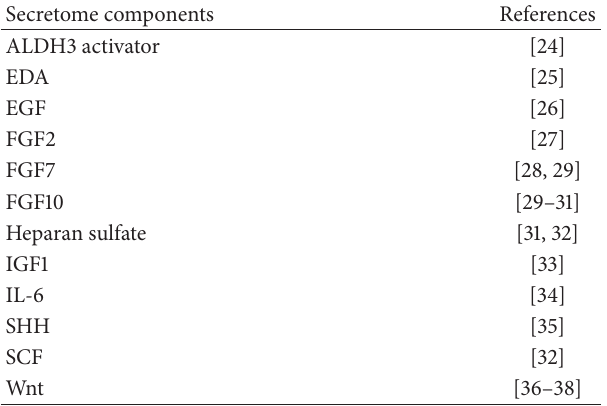
Table 1: List of secretome components (matrix peptides, cytokines, growth factors, and enzymes) from SG cell lines that can be potentially used in SG regeneration strategies. More details about each secretome component can be found in [18, 23].